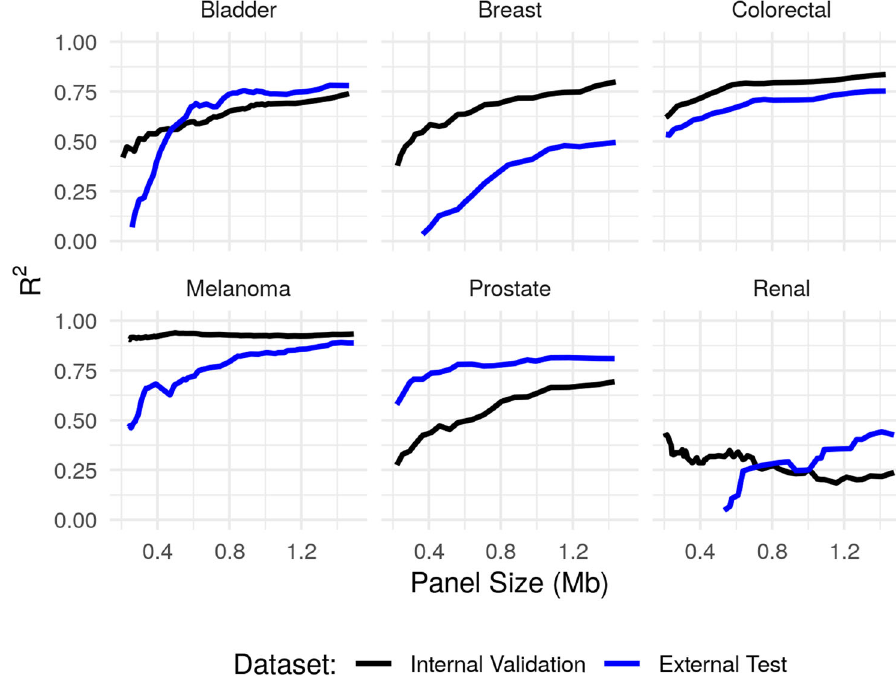
Fig. 8 Predictive performance on six further cancer types. The performance of our re fi tted TMB estimator in the six further cancer